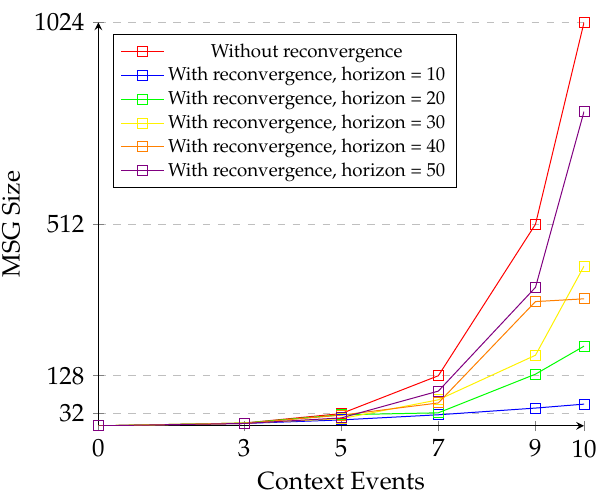
Figure 9. MSG with reconvergence for 20 jobs.